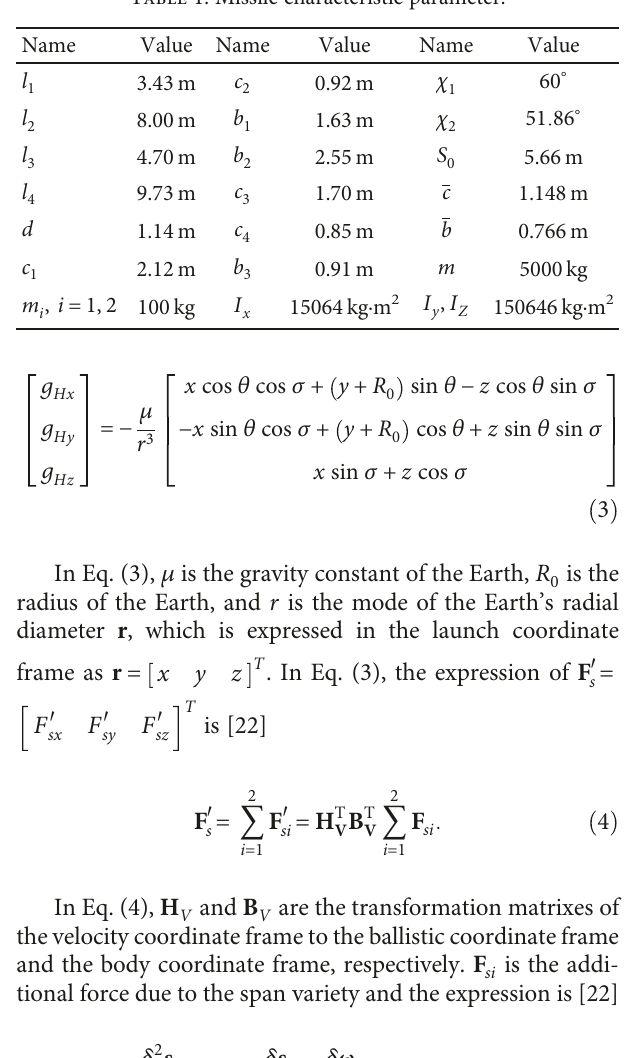
Table 1: Missile characteristic